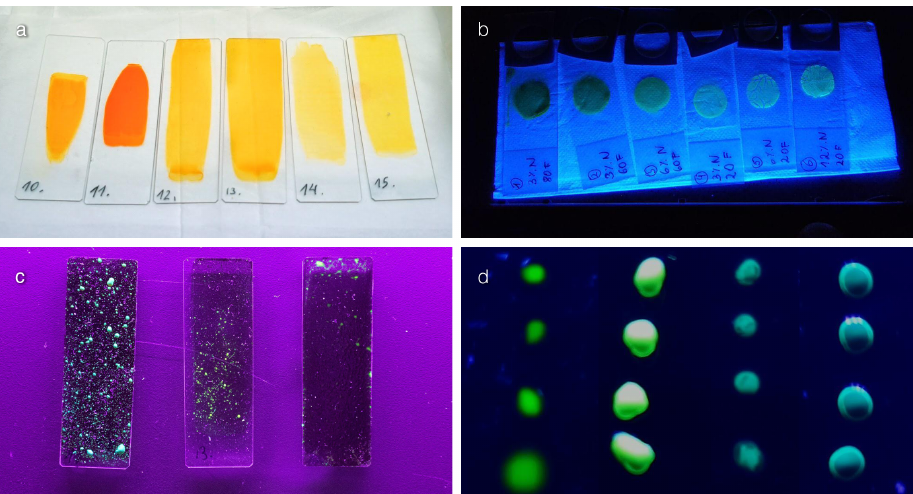
Figure 9. ( a ). Films with PVA matrix created using 20 µ m bar coater. ( b ). Films with Nafion matrix. ( c ). Droplets of 4.5 M sulfuric acid (left), 0.1 M sulfuric acid and deionized water on coated microscope slides. The droplets were sprayed from a distance of approx 20 cm. While the droplets of concentrated sulfuric acid remain visible on the surface for longer, the fluorescence signal disappears in a couple of seconds. ( d ). Bar coater method slide with deionised water; 0.1 M, 4.5 M and concentrated sulfuric acid test droplets (left to right). Plates visible in subfigures ( b – d ) are illuminated with a 385–400 nm UV-A LED light source, plate a is shown in regular room light (fluorescent light